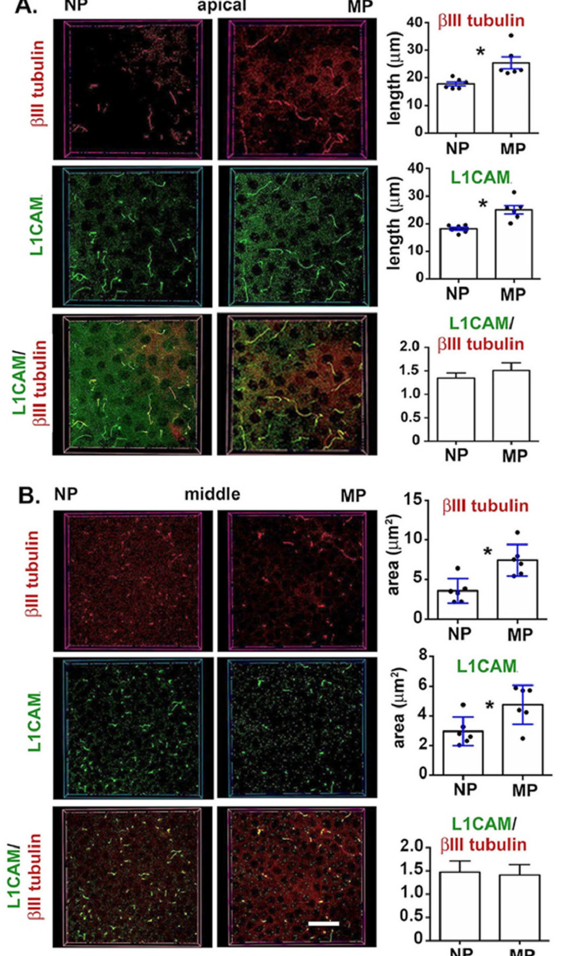
Figure 7. Parallel intraepithelial corneal nerve terminals (pICNTs) are longer in 9M in MP mice. After staining corneas with antibodies against both β III tubulin and L1CAM, the lengths of the pICNTs and ICNT areas were assessed in en face confocal images at apical ( A ) and middle ( B ) regions of the cornea, respectively. pICNTs and ICNTs are longer and larger in area in MP compared to NP mice. Bar = 50 μ m. Asterisks indicate significant differences with p values <0.05. Data show that the pICNTs are significantly longer in the apical cell layers and significantly larger in middle layers of the MP corneas compared to NP at 9M whether assessed by β III tubulin or L1CAM. These data indicate that nerve terminals are larger and grow longer in the MP corneas. The ratios of L1CAM/ β II tubulin in the apical and middle regions are similar for 9M NP and MP 9M corneas. The reduced sizes of the ICNTs and shorter lengths of the pICNT in NP corneas do not appear to be due to increased protease activity in the corneal epithelium since L1CAM is retained similarly on β III tubulin+ MP and NP nerve terminals. 3. Discussion The data presented here show that parity in female mice delays age-related loss of axon density and corneal sensitivity and it does so via a mechanism that appears to involve elevated NGF levels. NGF was the first growth factor characterized [22,23] and has been studied as a trophic factor for the